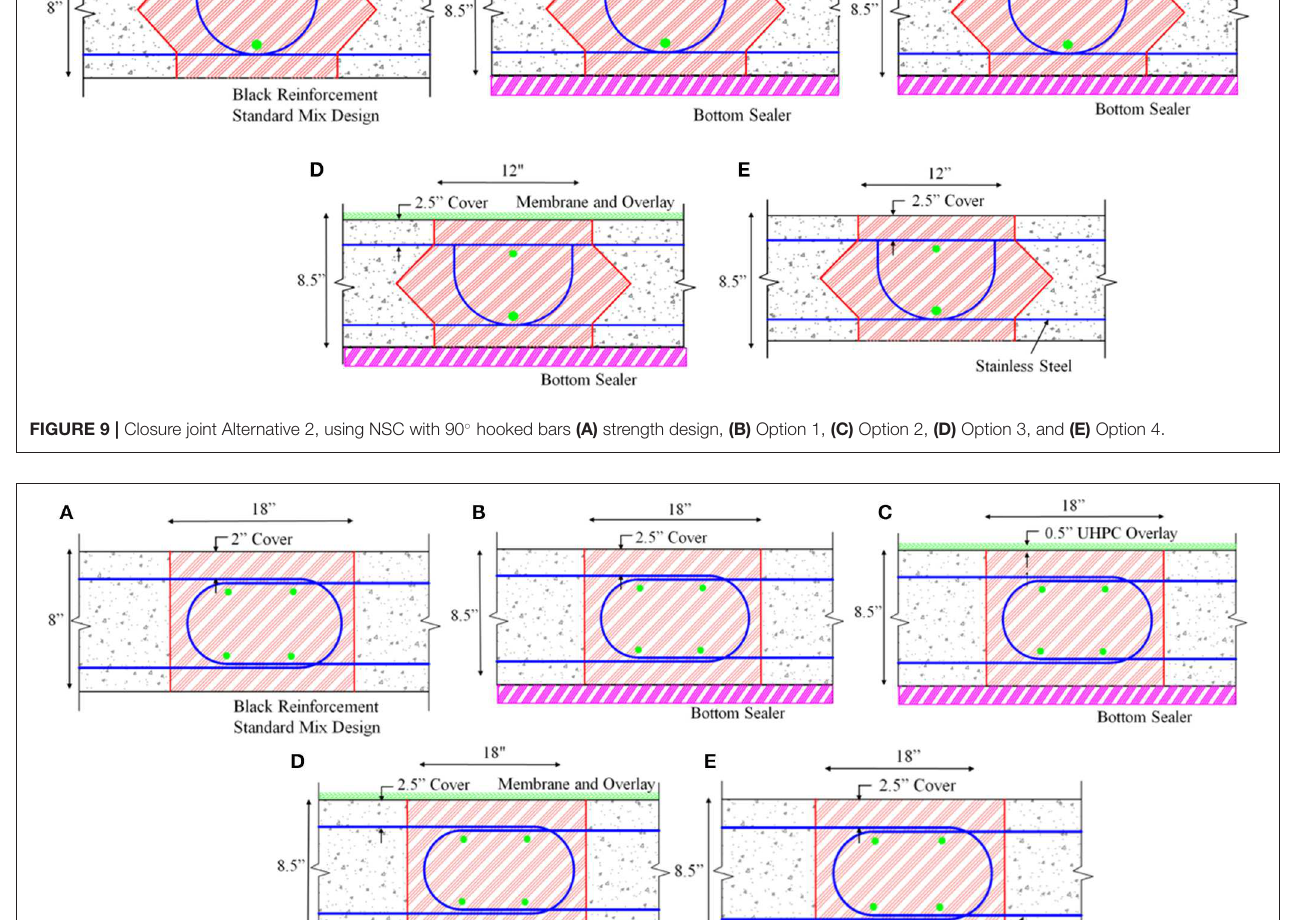
closure joints, therefore controlling the volume of the filler material. Black and stainless steels are also available, which have a difference in unit cost and corrosion resistance.